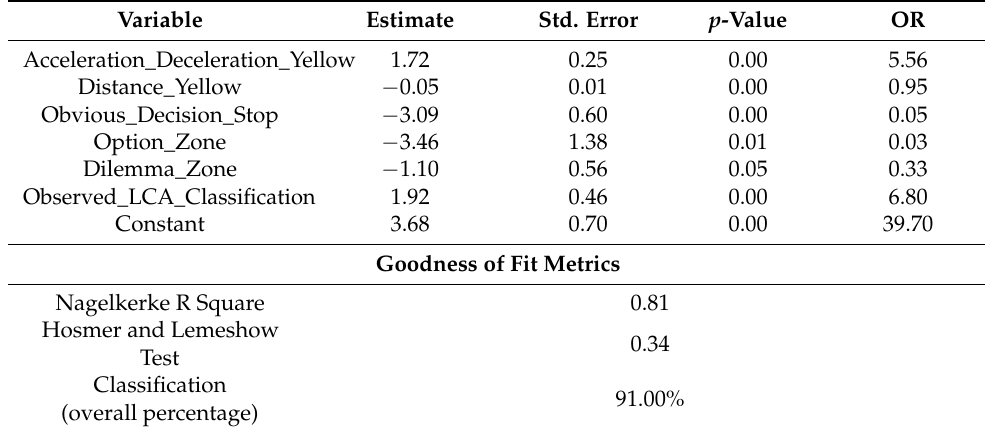
Table 9. Parameter estimates of the final binary choice